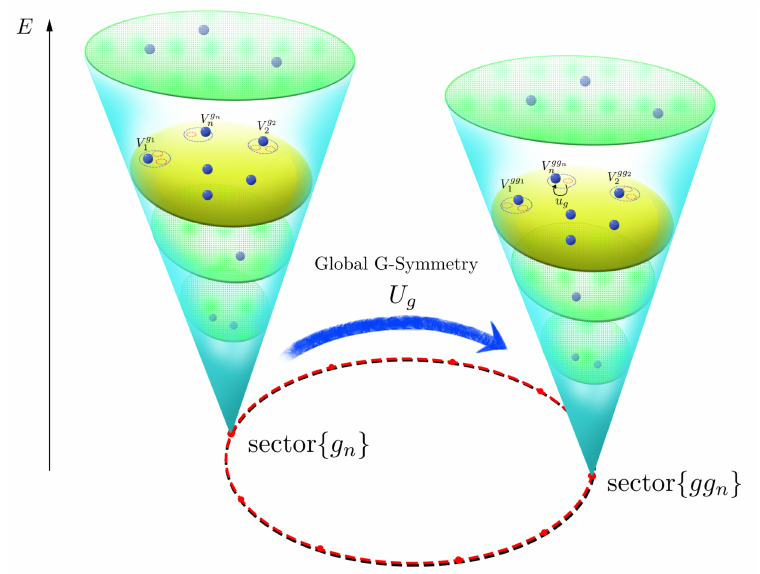
Figure 2 . A global transformation U g maps the sector with parameter { g n } to one with { gg n } . An anyon with topological charge V g n G on Rep A